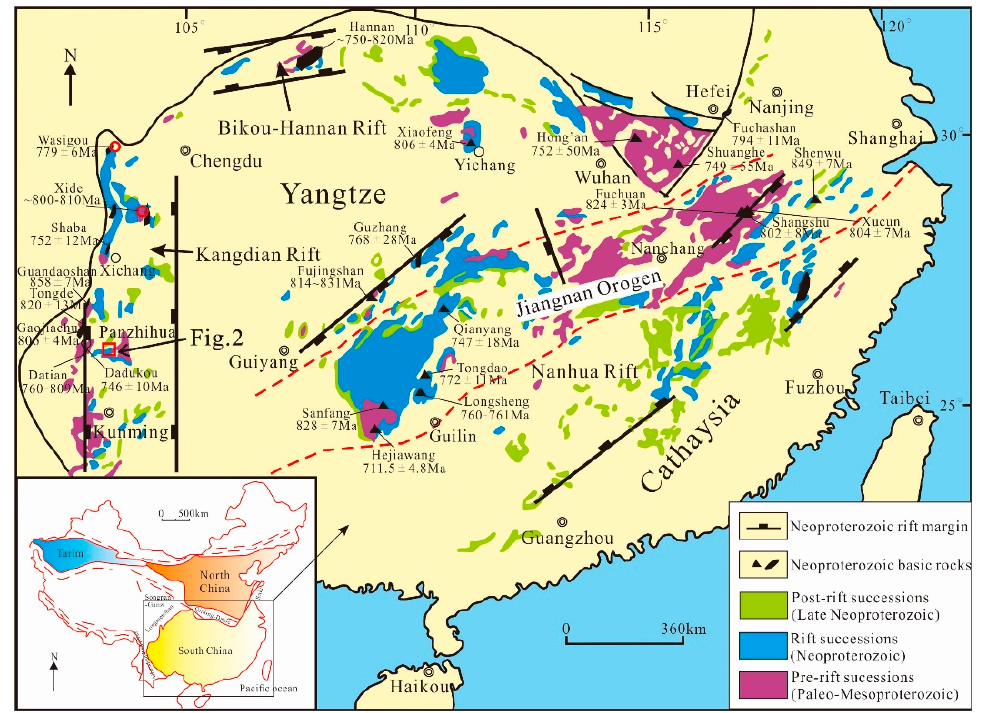
Figure 1. Schematic map of Precambrian South China Block (SCB) emphasizing the three Neoproterozoic rift basins and distribution of Neoproterozoic basic rocks (after [3,28,41,42]). The inset is a tectonic sketch of China showing the three Precambrian blocks (after [43]). Detailed data of the basic rocks in the Yangtze Block (YZB) can see in Table S1.